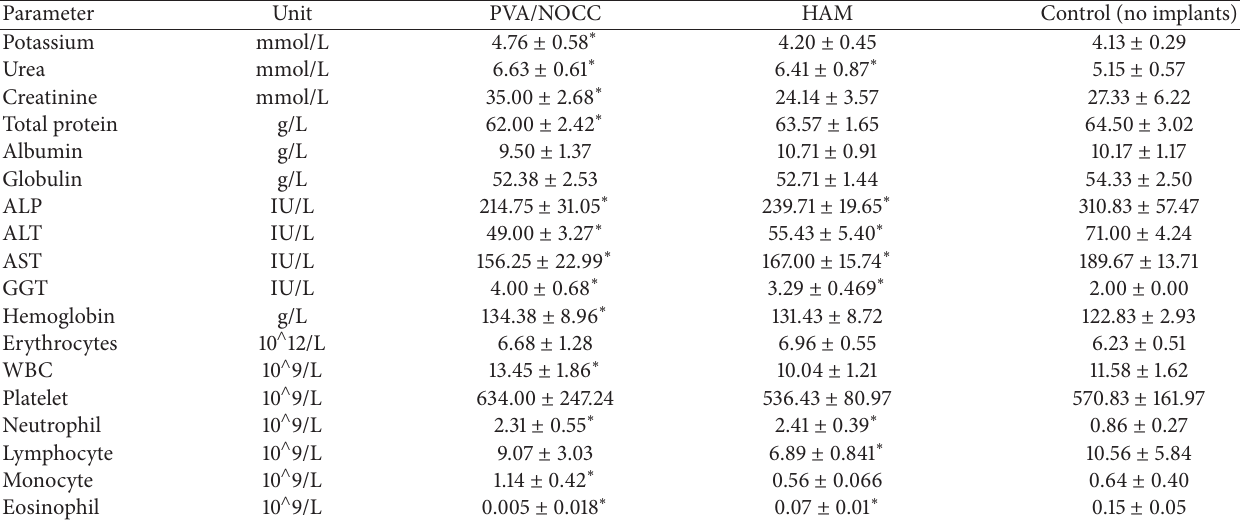
Table 1: Differences in the level of some biochemical indicators among groups of animals implanted with PVA/NOCC and HAM and control on the 5th day of implantation (mean ±